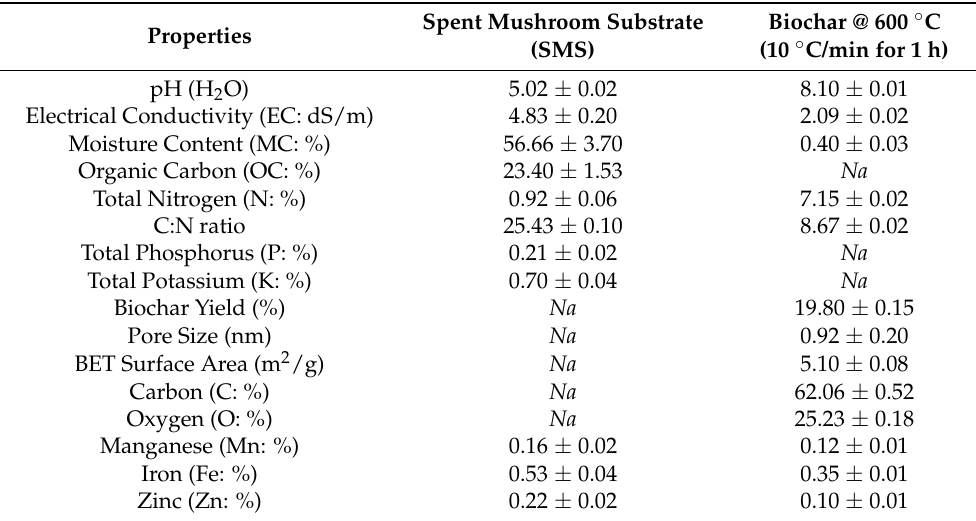
Table 1. Physicochemical, nutrient, and morphological properties of the spent mushroom substrate (SMS) and its